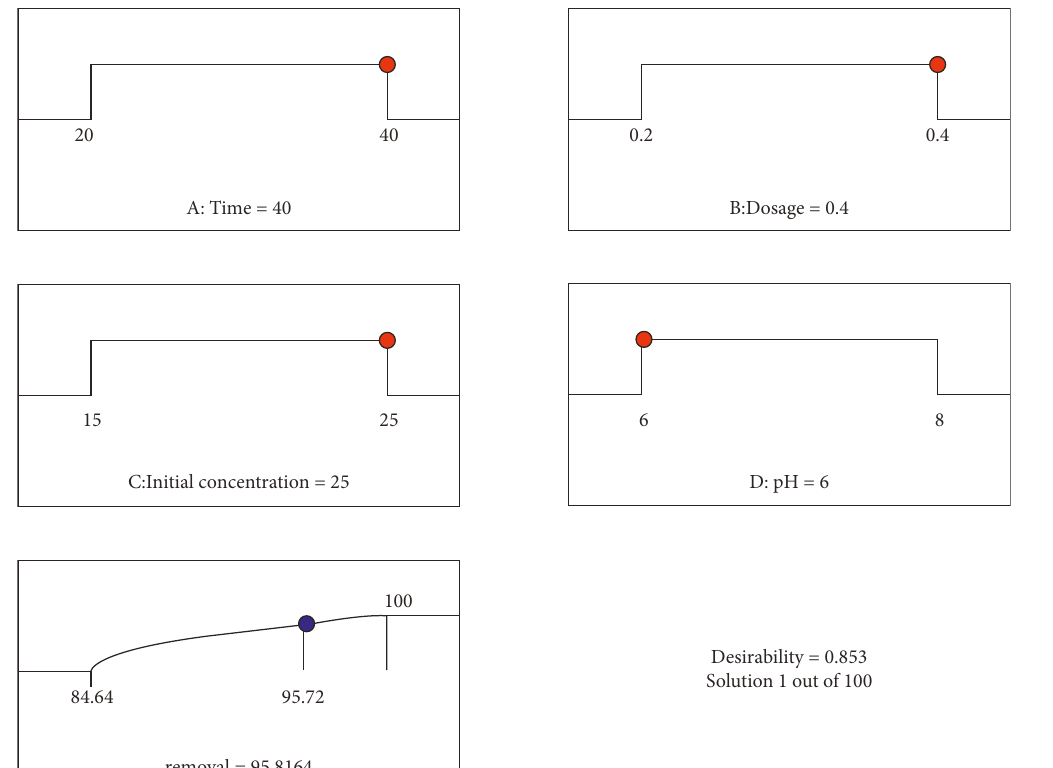
Figure 5: Desirability plot for adsorption.